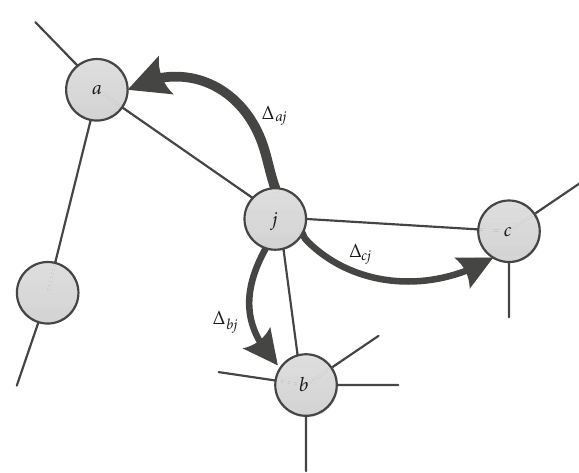
Figure 2: An example of load-redistribution